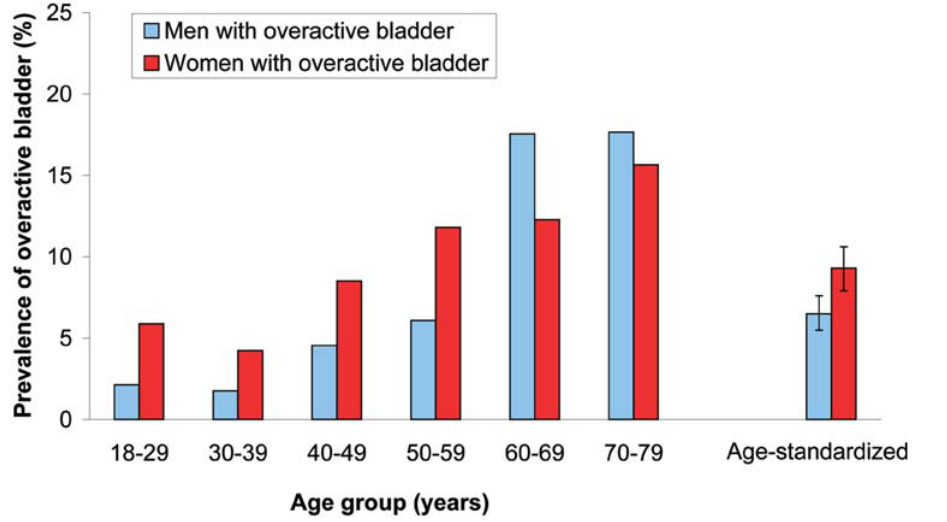
Figure 2. The prevalence of overactive bladder in Finland, 2003–2004. The blue bars indicate men with overactive bladder and the red bars women with overactive bladder. Age-standardization was performed using the general population [21].